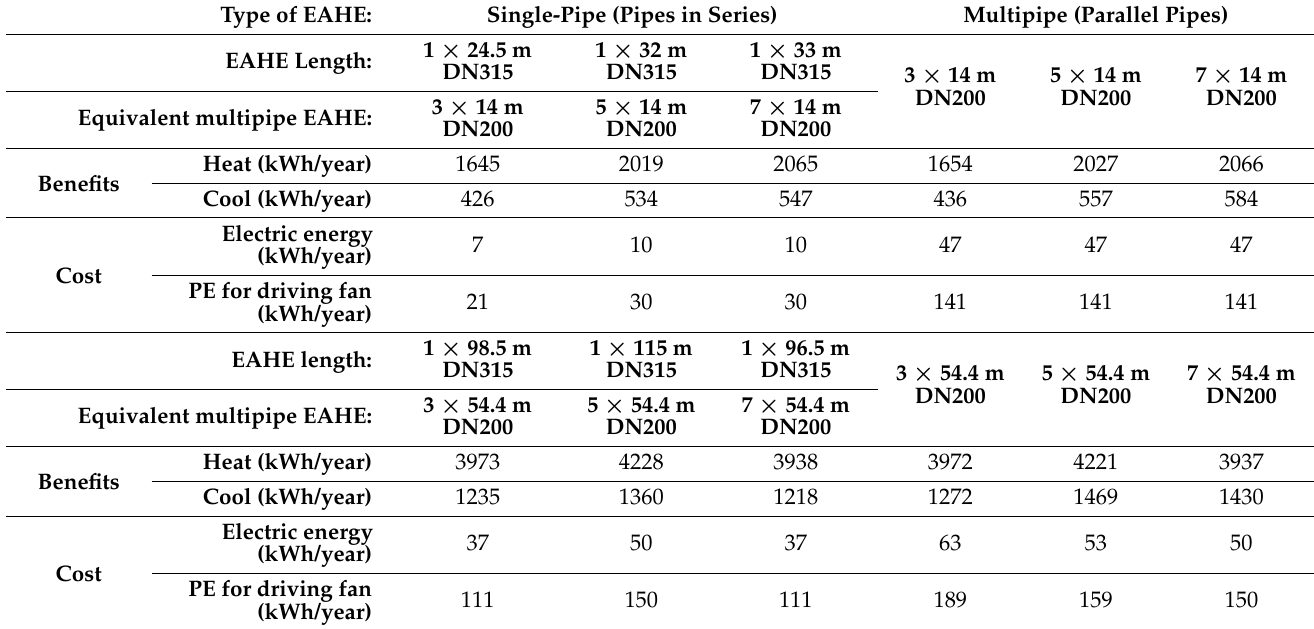
Table 9. Equivalent length of DN315 single-pipe EAHE replacing a given multipipe exchanger in terms of heat; the results of calculations of annual electricity consumption and primary energy consumption for fan drive, V = 600 m 3